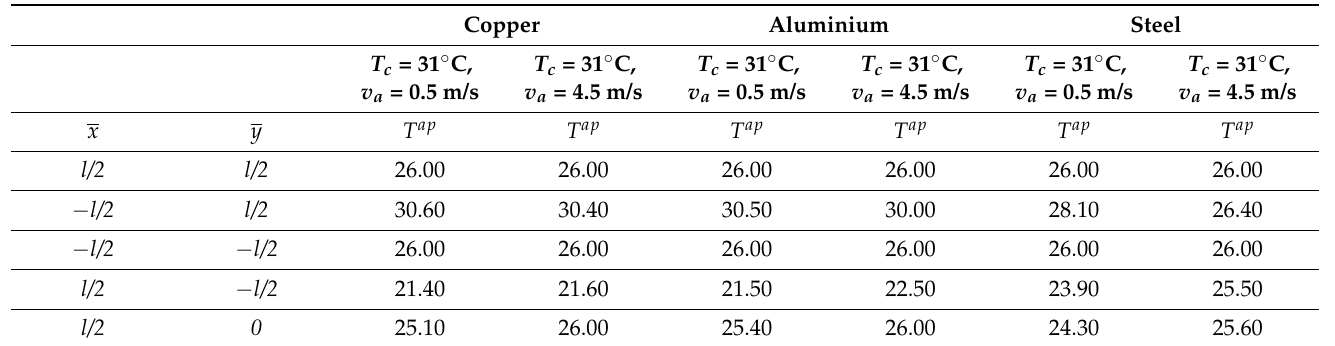
Table 11. Temperatures in the corners of different plates and at the midpoint of the plate’s surface facing the heated air inlet to the room for different values of T c , v a , t = 300 s, and T c = 31 ◦ C.